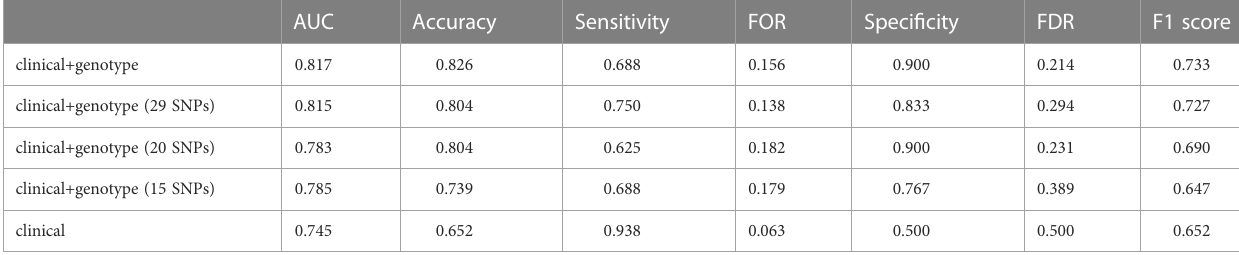
TABLE 2.2 Predictive performance of different NSLN metastasis predictive models in external validation, among different clinical nomogram models. AUC Accuracy